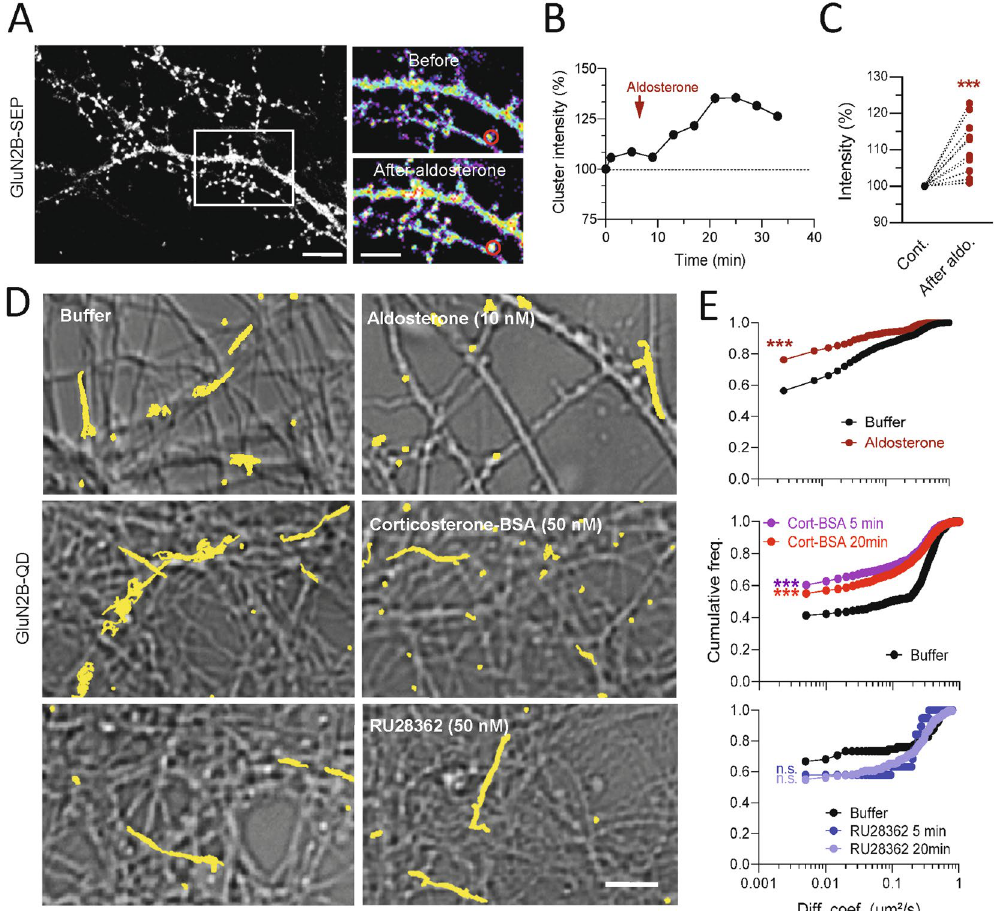
Figure 5. Aldosterone, a MR activator, alters the surface distribution and dynamics of GluN2B-NMDAR. ( A ) Dendritic fragments of GluN2B-SEP expressing neurons before and after exposure to aldosterone (10 nM). Scale bar = 5 µ m, scale bar inset = 1 µ m. ( B ) Example of fluorescence intensity of GluN2B-SEP clusters over time, before and after aldosterone application. ( C ) Comparison of GluN2B-SEP cluster fluorescence intensity before and after exposure to aldosterone (10 nM, 25 min exposure; n = 10 dendritic fields, N = 5 neurons). *** p < 0.001, paired Student t-test. ( D ) Representative trajectories of single GluN2B-NMDAR in hippocampal neurons (DIC images) exposed to either buffer solution, aldosterone (10 nM, 20 min), corticosterone BSA (50 nM, 20 min), or RU28392 (GR agonist, 50 nM, 20 min). Scale bar, 5 µ m. ( E ) Comparison of the cumulative distributions of GluN2B-NMDAR instantaneous diffusion coefficients between aldosterone (buffer, n = 214 trajectories; aldosterone, n = 225 trajectories), corticosterone BSA (buffer, n = 539 trajectories; 5min corticosterone BSA, n = 855 trajectories; 20min corticosterone BSA, n = 864 trajectories), or RU28392 (buffer, n = 229 trajectories; 5min RU28392, n = 175 trajectories; 20min RU28392, n = 119 trajectories). *** p < 0.001, Kolmogorov-Smirnov